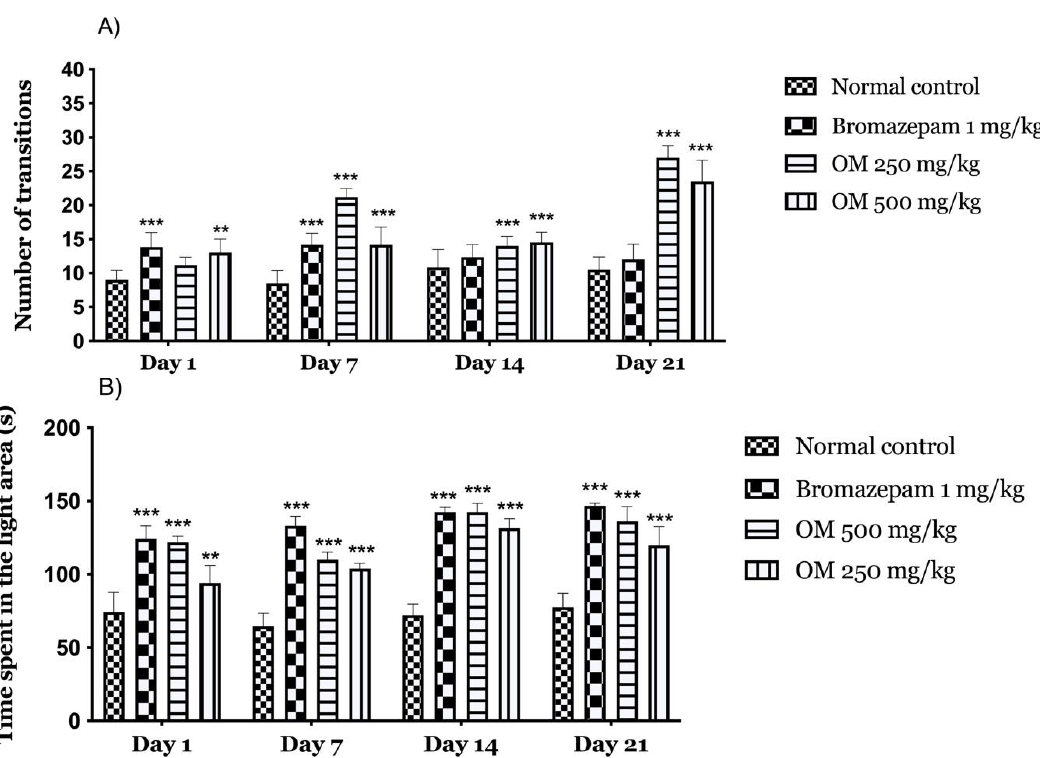
Figure 4. Temporal effects of OM in the light/dark box test ( A ) the number of transitions between the dark and light compartment ( B ) Time spent in the light area. Values are expressed as mean ± SEM.